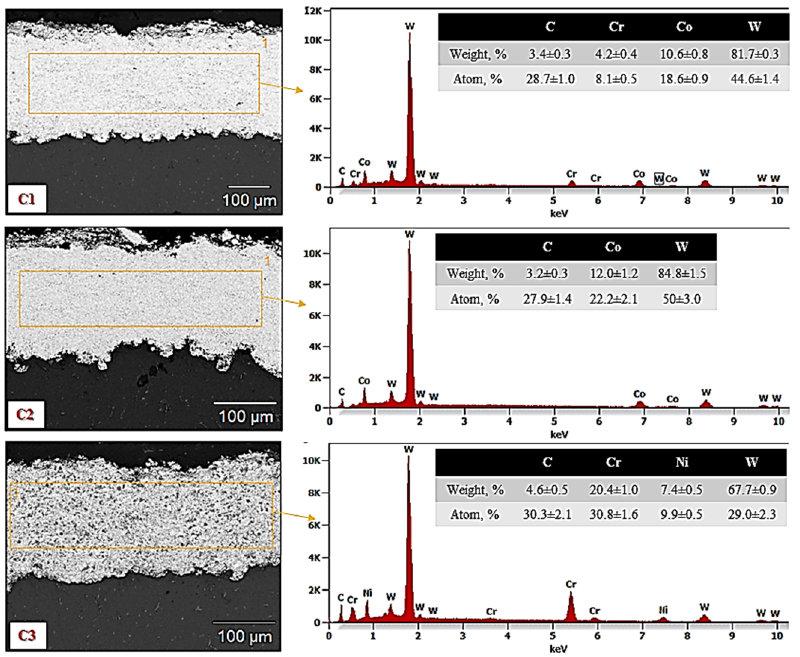
Figure 4. The chemical composition of the HVOF-sprayed coatings.